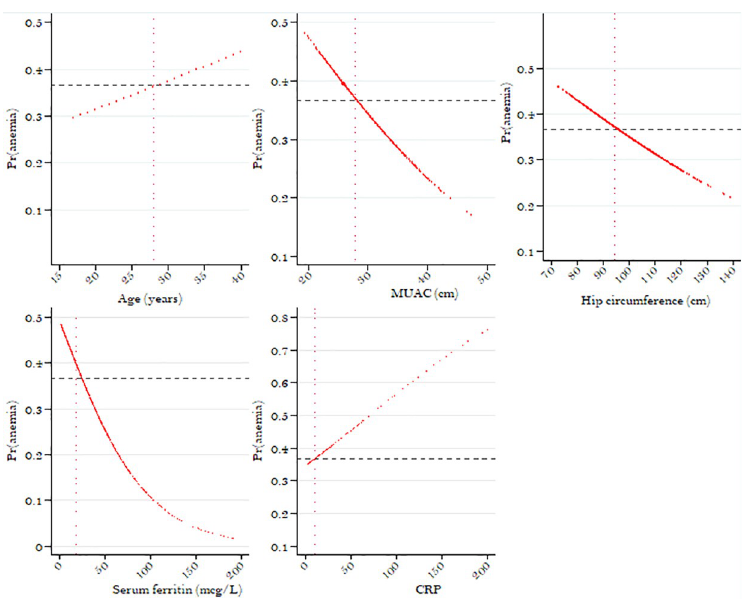
Fig 2. Trendline graphs of proportions of anemia by age, MUAC, hip circumference, s-ferritin and CRP among non-pregnant women in Korogwe.